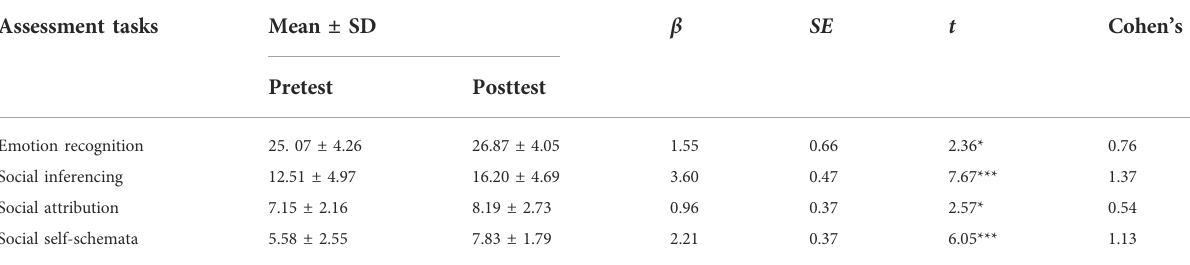
TABLE 3 Effects of time on assessment task